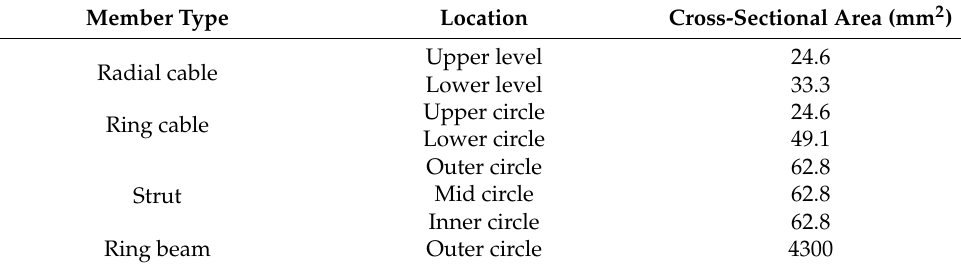
Table 1. Dimensions of the modified finite element model